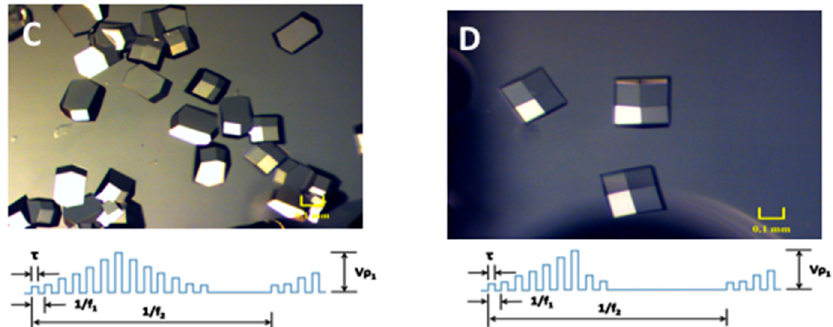
Figure 2. Four types of pulse waves were tested ( A – D ) as shown underneath each picture. The last pulse wave, where better crystals are obtained, is called breathing pulse wave.